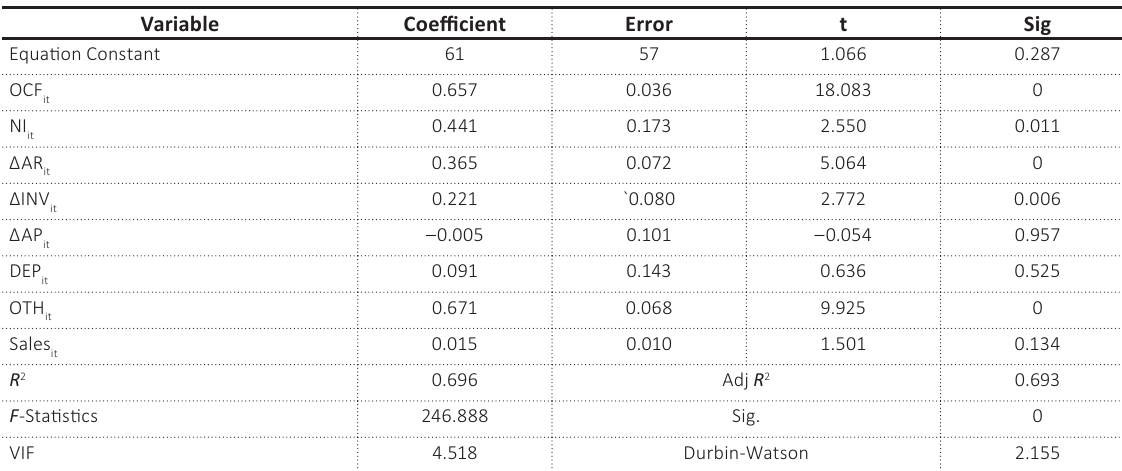
Table 4. Hypothesis